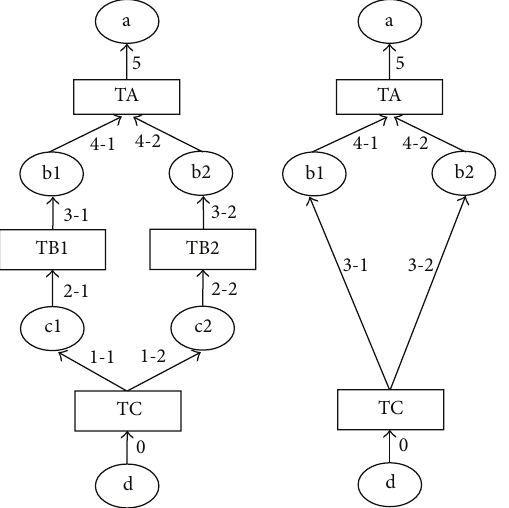
Figure 7: Reduction of parallel and synchronization structure model fragment.